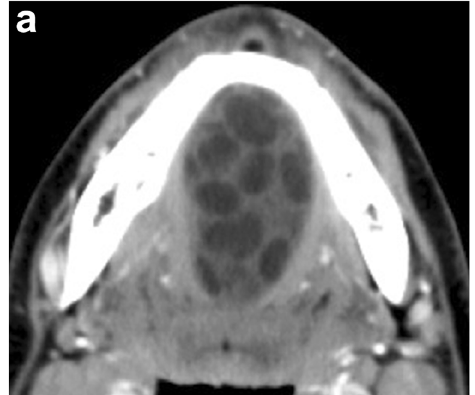
Fig. 3 Dermoid cyst. Axial contrast-enhanced CT image shows a lesion with globules of fat ( B sac of marbles ^ ) in a fluid medium splaying the genioglossus muscles laterally to their respective ipsilateral sides